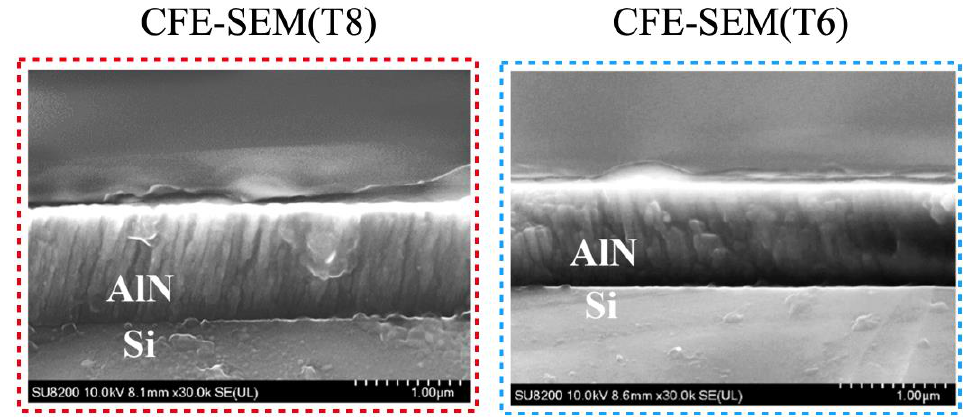
Figure 7. Cross-section CFE-SEM images and of a tensile group T8 and a compressive group T6.